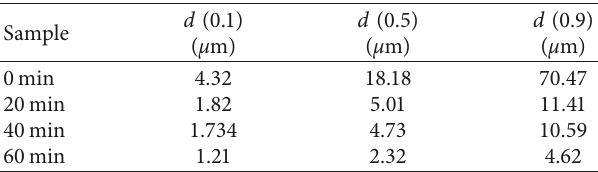
Figure 1: Different particle size distributions of slag particles at different wet milling durations. Table 1: The main integral distribution of slag powder at different wet grinding